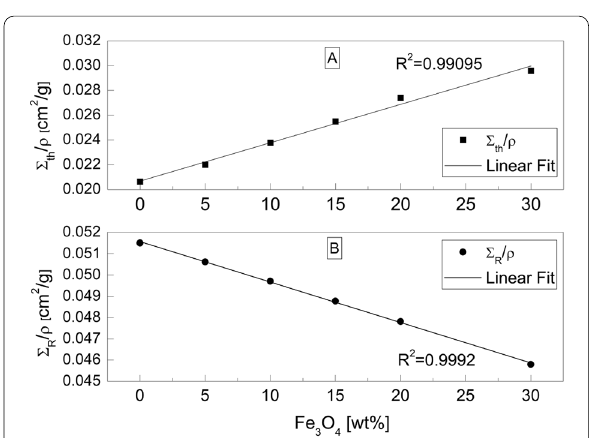
Fig. 9 Fast, slow, and thermal neutron macroscopic cross‑sections for all cementitious